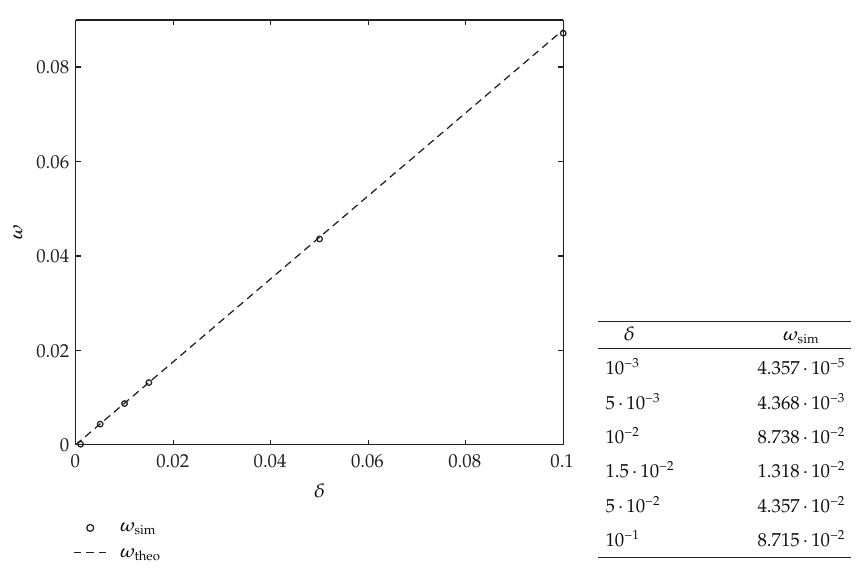
Figure 3: Transversal oscillation-frequency ω versus slenderness δ